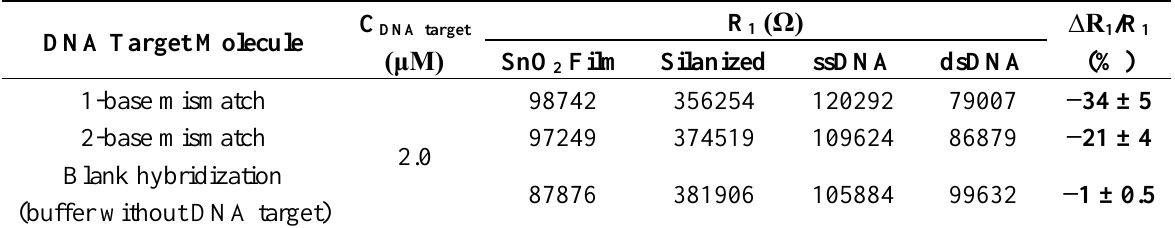
Figure 7. Evolutions of the polarization resistance ∆R 1 /R 1 (%) (black) and the fluorescence signal (blue) as a function of different types of DNA target: complementary, 1-, 2-base mismatch, non-complementary and hybridization buffer without DNA target (blank hybridization). Table 5. Vapour phase silanization: resistance value R 1 obtained from fitting experimental data to the equivalent circuit for DNA probe immobilized 220-nm-thick-nanoporous-SnO 2 electrodes after silanization, after DNA probe immobilization and after complementary DNA hybridization with different types of target molecules. The target concentration was fixed at 2